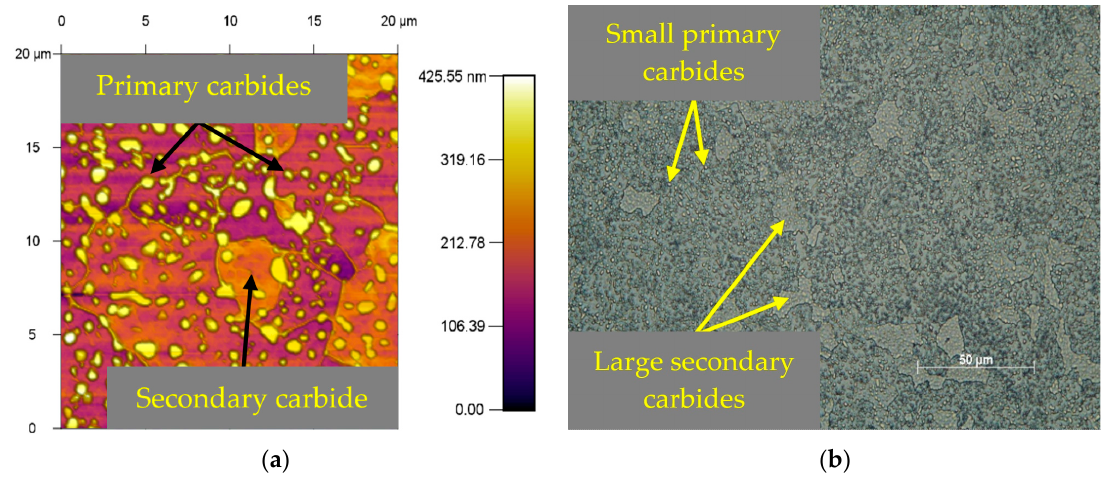
Figure 2. Basic microstructure of tool steel 90MnCrV8: ( a ) AFM, ( b ) LOM